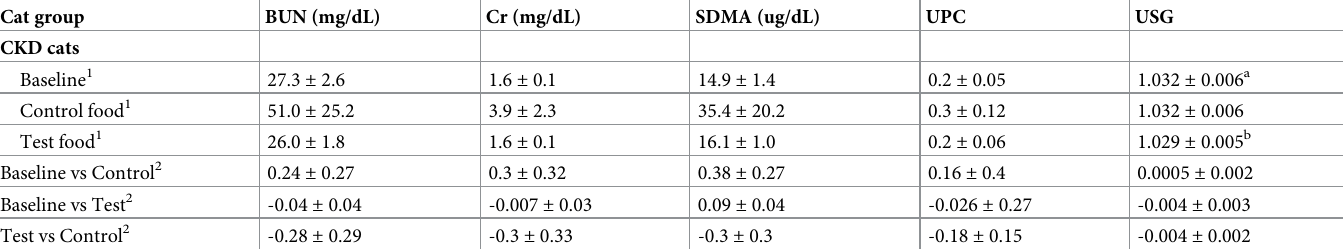
(n = 3), as well as a nonazotemic cat with a missing kidney based on physical examination and ultrasonographic imaging (n = 1; right kidney missing). Proteinuria was classified as border- line proteinuric if urine protein/creatinine (UPC) ratio was 0.2 to 0.4, and proteinuric if UPC ratio was > 0.4. The three azotemic cats were borderline proteinuric at baseline. One nonazo- temic cat with kidney stones became azotemic and proteinuric after consuming control and test foods. No CKD cats were removed from the study. A matched-paired t test using natural log transformed values was performed to determine differences between cats in serum and urine kidney function biomarkers after consuming test vs control food, and differences within CKD cats from baseline vs after consuming control food, and from baseline vs after consuming test food ( Table 3 ). Only USG for baseline vs after consuming test food was significantly differ- ent (decreased P = 0.046) for CKD cats.